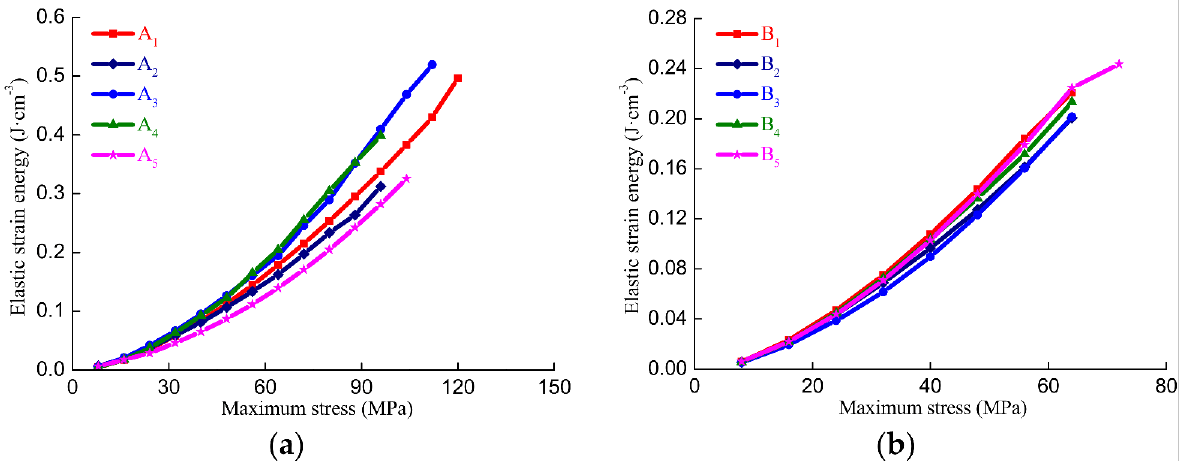
Figure 4. Elastic strain energy during cyclic loading and unloading of sandstone. ( a ) Dry rock samples. ( b ) Saturated rock